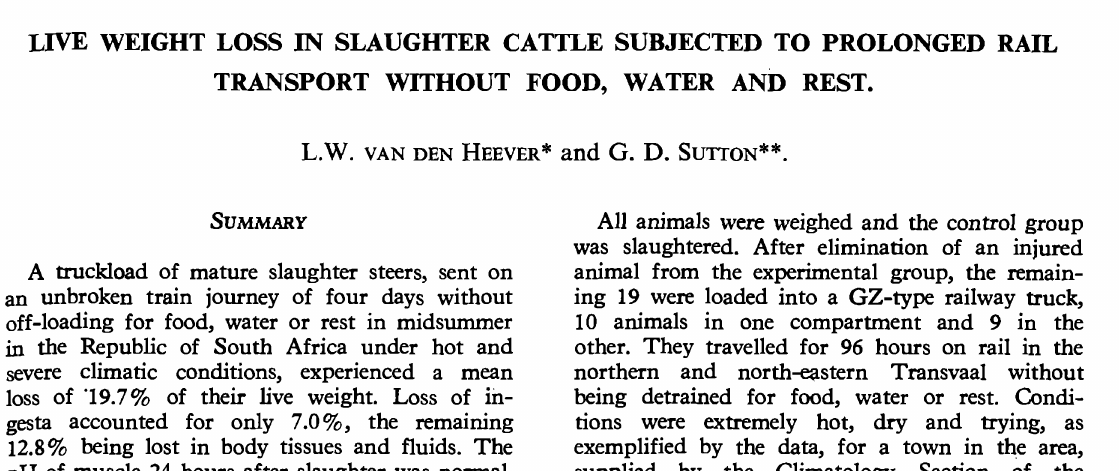
TABLE l.---CLIMATOWGICAL DATA AT POTGIETERSRUST DURING EXPERIMENTAL